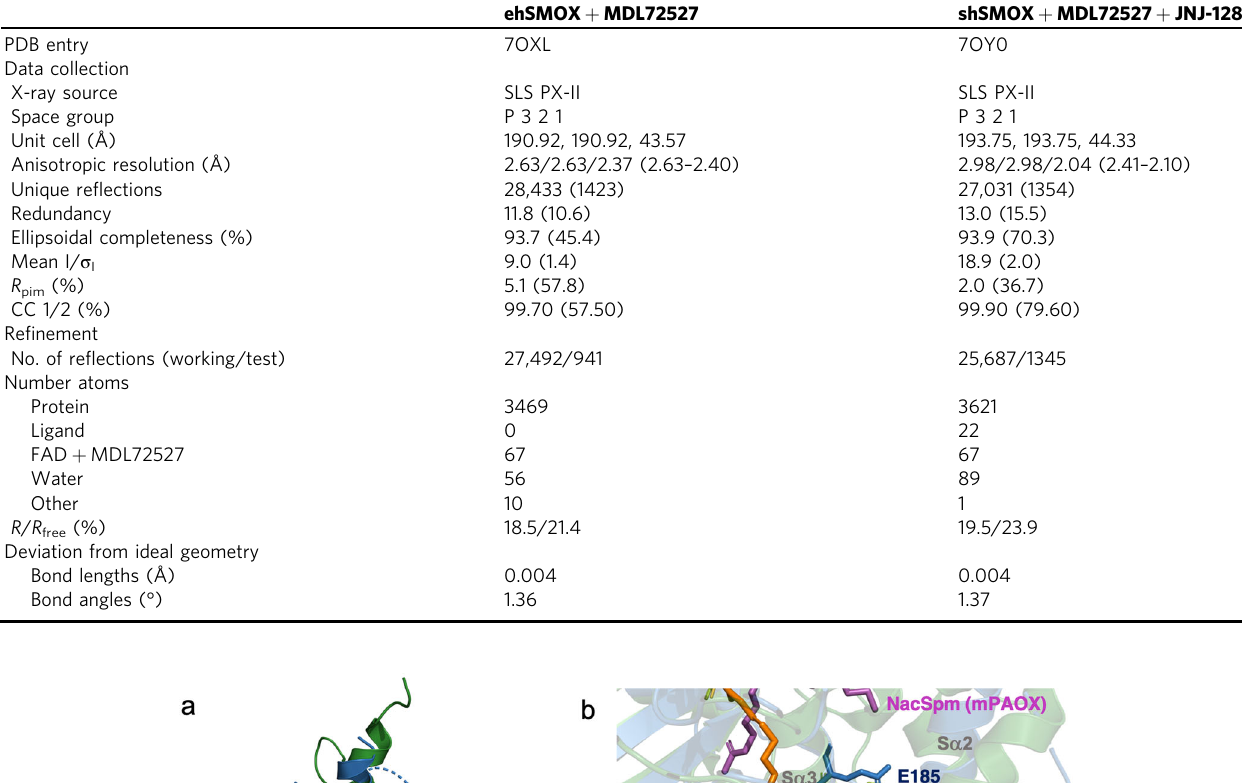
Table 1 Data collection and re fi nement statistics.